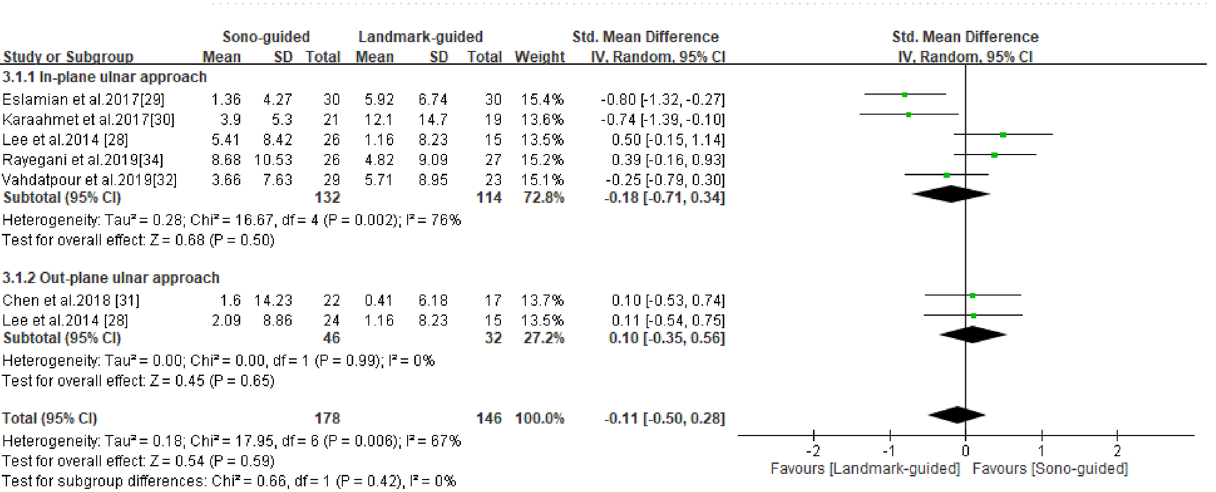
Figure 5. Forest plot for SNAP. US-guided, ultrasound guided; LM-guided, landmark guided.